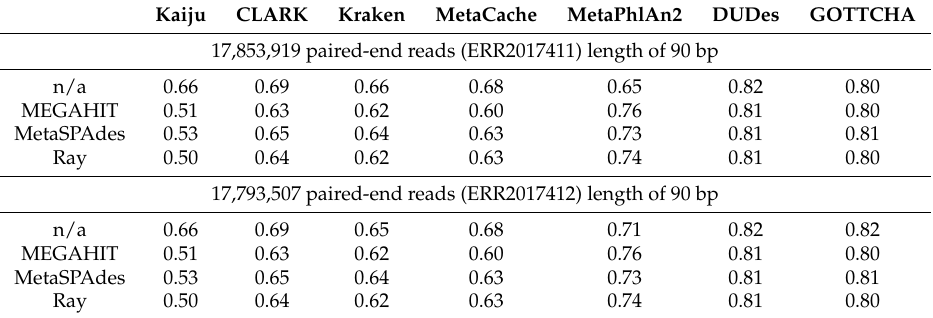
Table 4. Pairwise similarity of a method to other